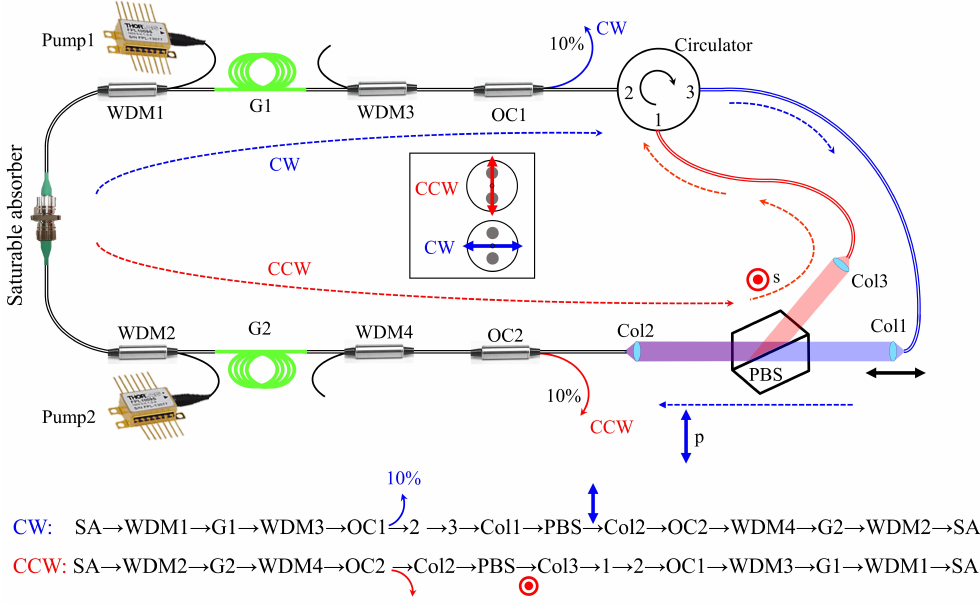
Figure 2. Schematic of the PM fiber laser cavity generating two cross-polarized counter-circulating pulses. WDM: wavelength division multiplexer, G: gain fiber, OC: output coupler, Col: collimator, PBS: polarizing beam splitter, s: s-polarized, p: